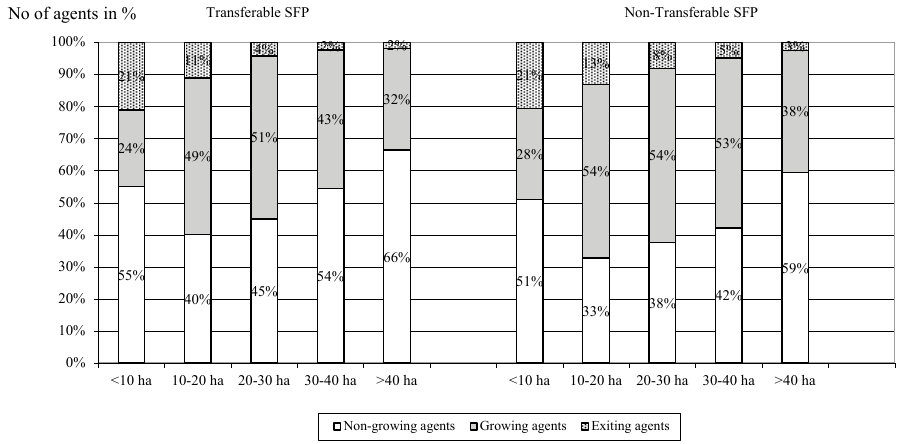
Figure 6. Share of growing, non-growing and exiting agents in different farm-size categories